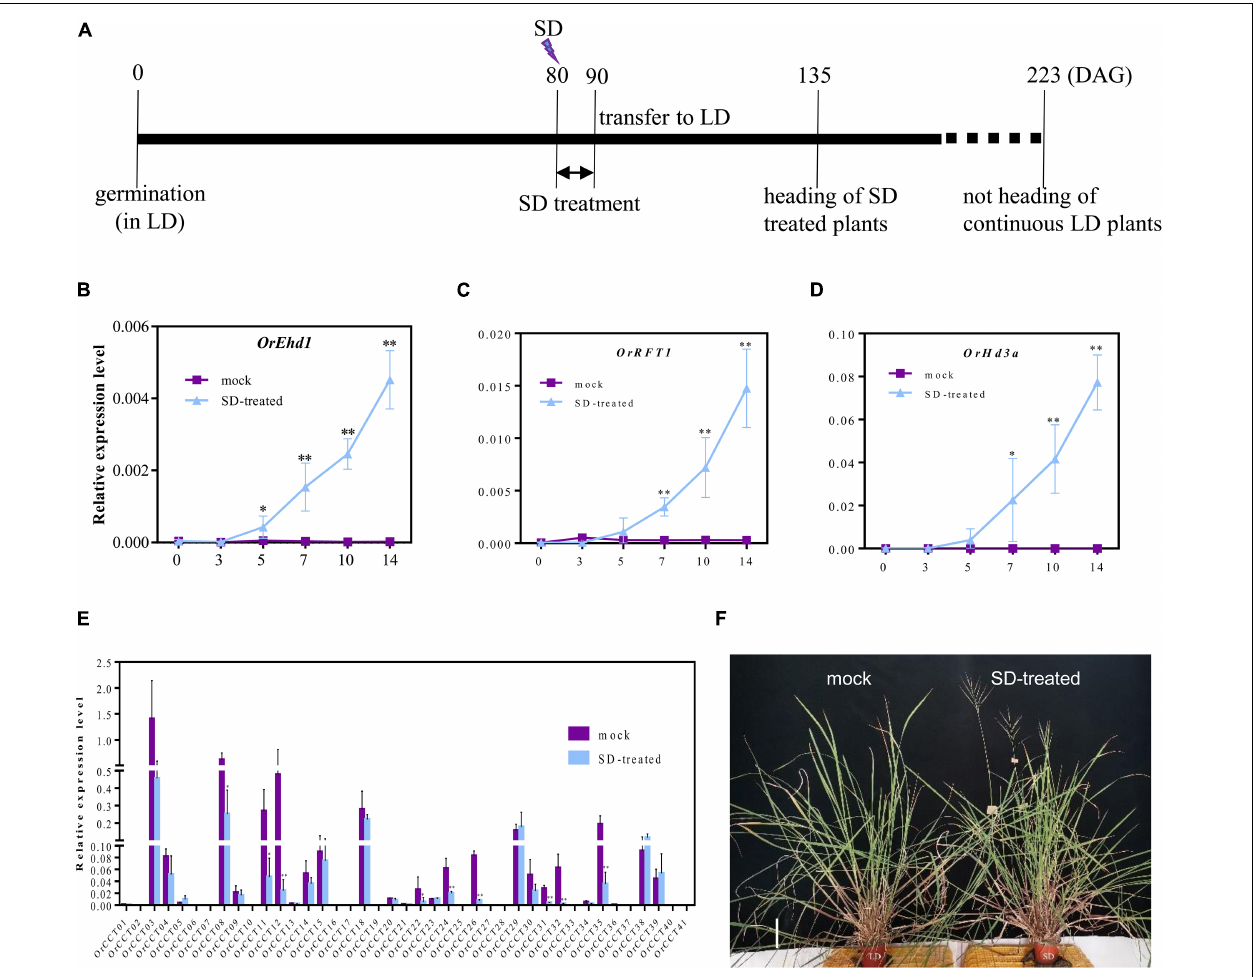
FIGURE 7 | The response to SD-induction starting from 80 DAG in O. rufipogon (CWR1). (A) Scheme of SD treatment; (B–D) The expression level of OrEhd1 (B) , OrRFT1 (C) , and OrHd3a (D) in the leaf blades of CWR1 plants with mock and SD-treatment. The x -axis presents the days of SD treatment. (E) The transcript level of 41 OrCCT genes in the leaf blades of O. rufipogon (CWR1) after 10 days of SD-treatment. The transcript levels were relative to OsUbi1 . Values are means ± SD ( n = 5). *, ** significant differences by Student’s t -test at P ≤ 0.05 and P ≤ 0.01, respectively. (F) The phenotypes of O. rufipogon (CWR1) plants with mock and SD-treatment (right) at 140 DAG. Bar = 10 cm in (F)